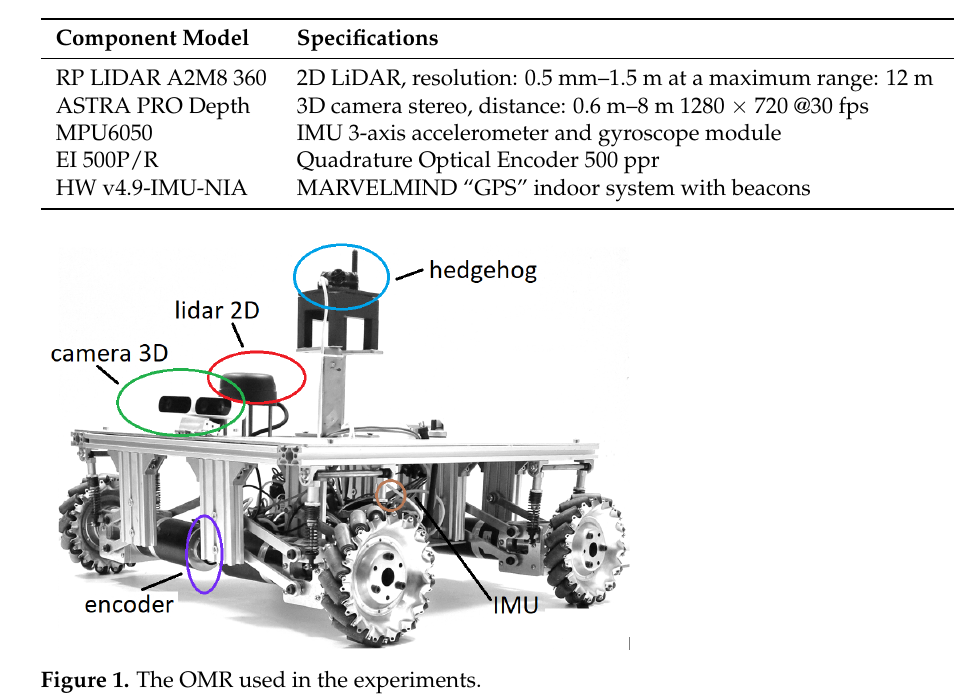
Table 1. Components of the perception system.